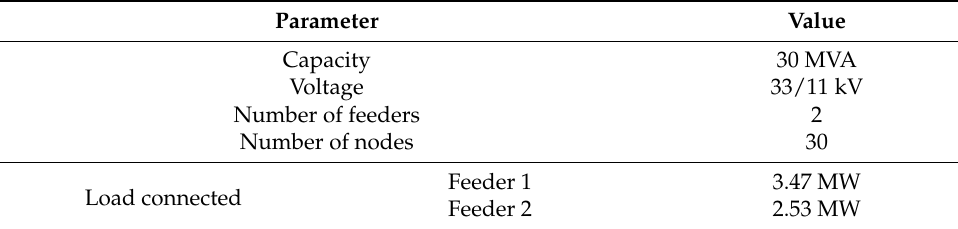
Table 1. Basic network parameters of the test